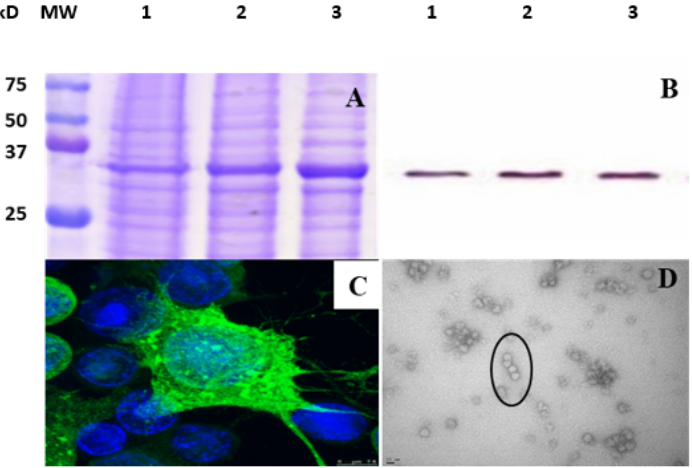
Figure 2. Characterization of the ultracentrifugation-purified VP1-VLP vaccine particles. ( A ) SDS- PAGE analysis of the three different fractions (Lanes 1–3) of ultracentrifugation-purified VP1-VLP. MW: molecular weight marker (10–250 kD). ( B ) Western blot analysis of puri fi ed VP1-VLP revealed that the VP1-VLP were recognized by an anti-enterovirus VP1 5D-8/1 clone monoclonal antibody